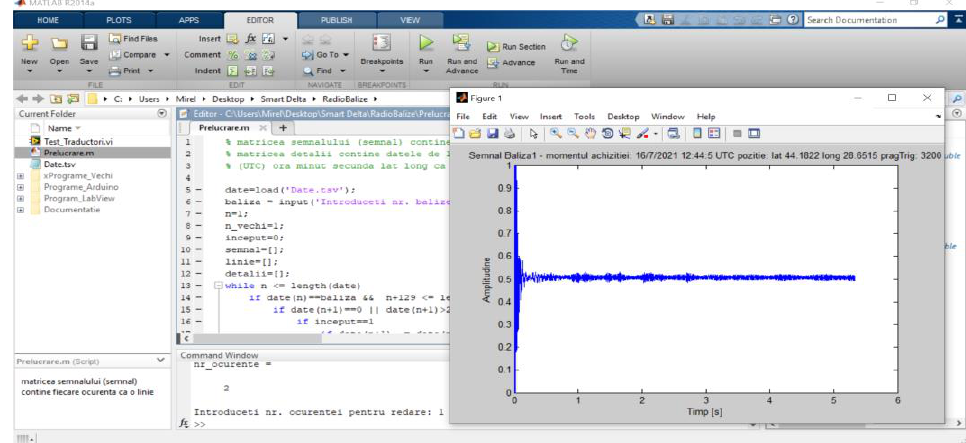
Figure 10. Selecting a signal from the stored database.